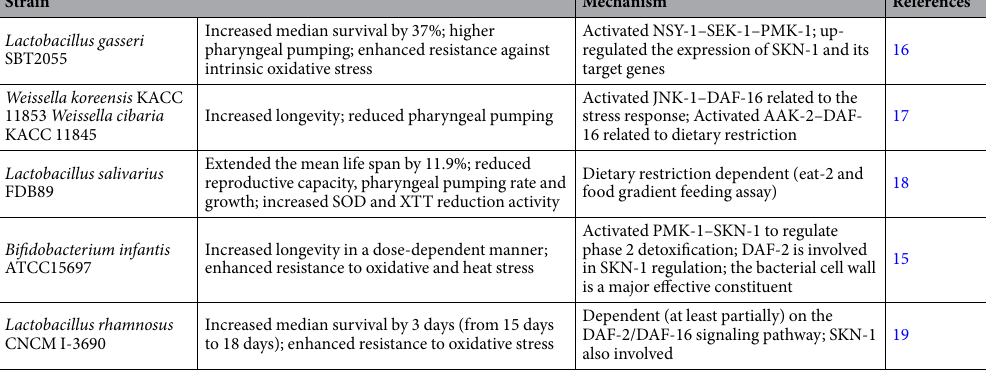
Table 1. Summary of the effect of probiotics on the longevity of C. elegans